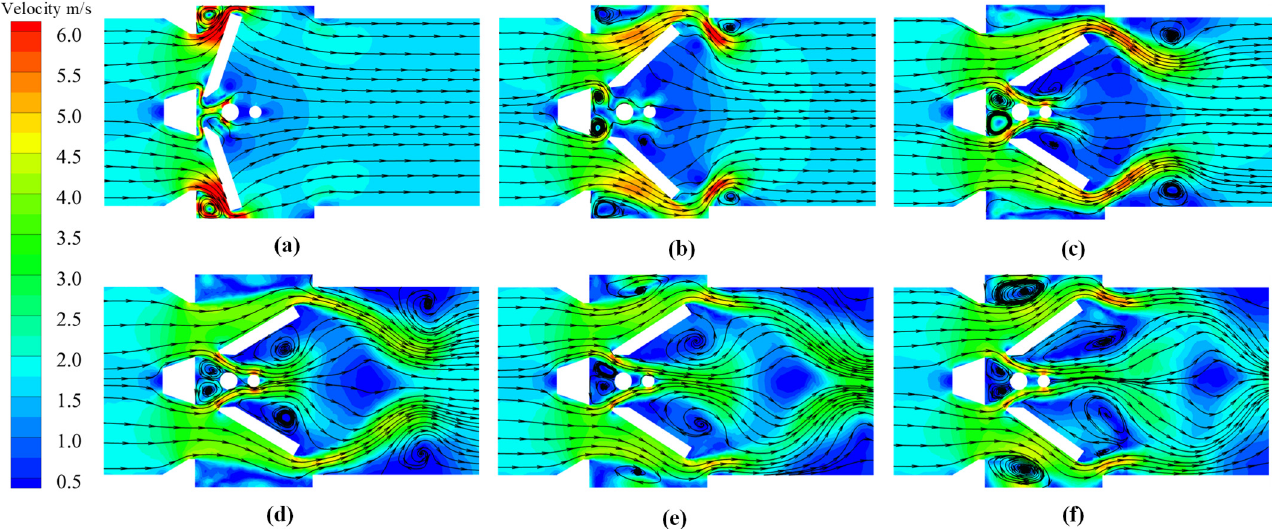
Figure 12. The instantaneous flow field diagram of the valve opening, Scheme 6. ( a ) Flow time = 0.1 s; ( b ) Flow time = 0.3 s; ( c ) Flow time = 0.5 s; ( d ) Flow time = 0.7 s; ( e ) Flow time = 0.9 s; ( f ) Flow time = 1.1 s.